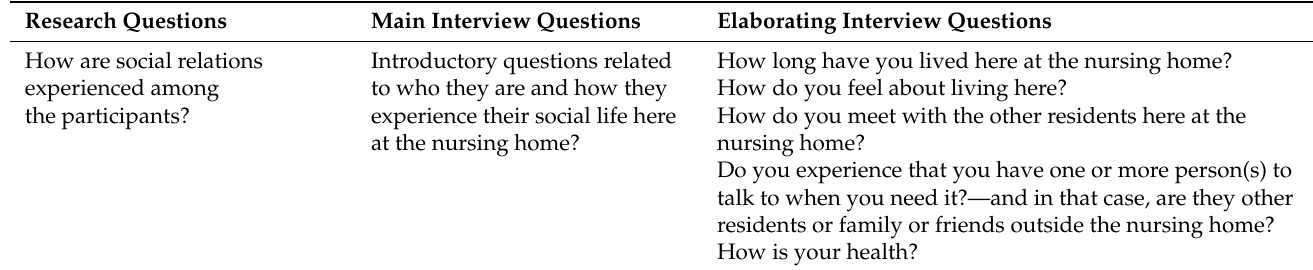
Table A1. Interview guide for nursing home